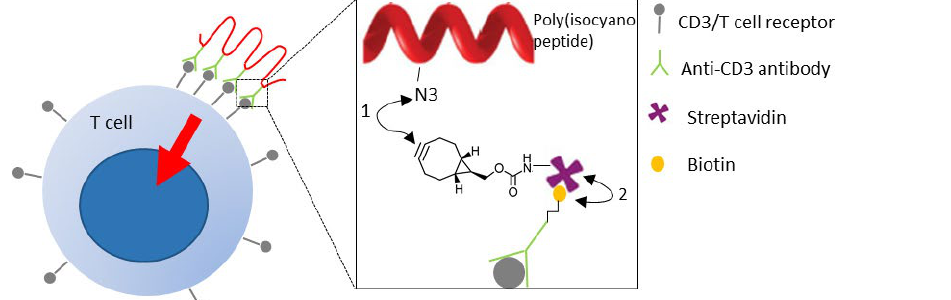
Figure 2. Artificial antigen presenting cells to activate T cells. Poly (isocyano peptide) is conjugated to an anti-CD3 antibody that activates T cell signalling upon binding T cell receptors. (1) Azide groups of poly (isocyano peptide) were coupled to bicyclononyne- functionalized streptavidin through a strain-promoted azide-alkyne click reaction (SPAAC); (2) streptavidin binds to biotinylated anti-CD3 antibodies